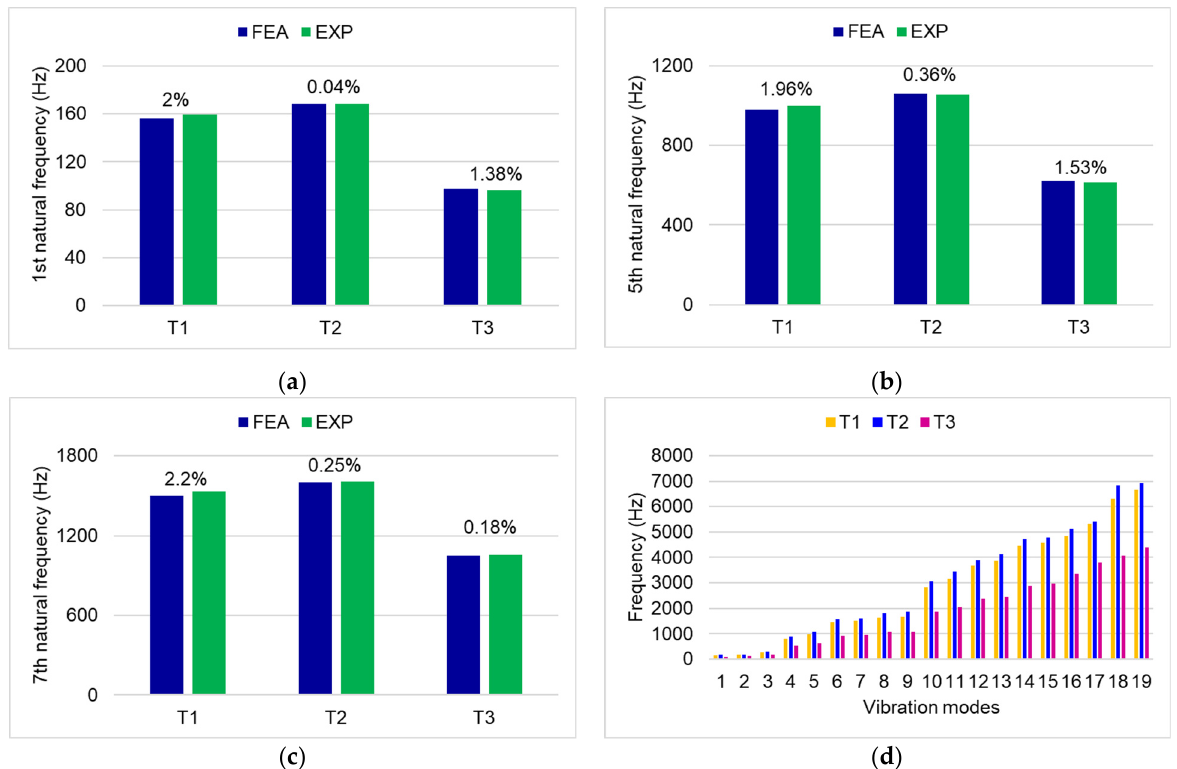
Figure 9. Comparison between experimental and numerical modal analysis: ( a ) first natural fre- quency; ( b ) fifth eigenvalue; ( c ) seventh eigenvalue; ( d ) frequencies spectrum obtained by FEA.